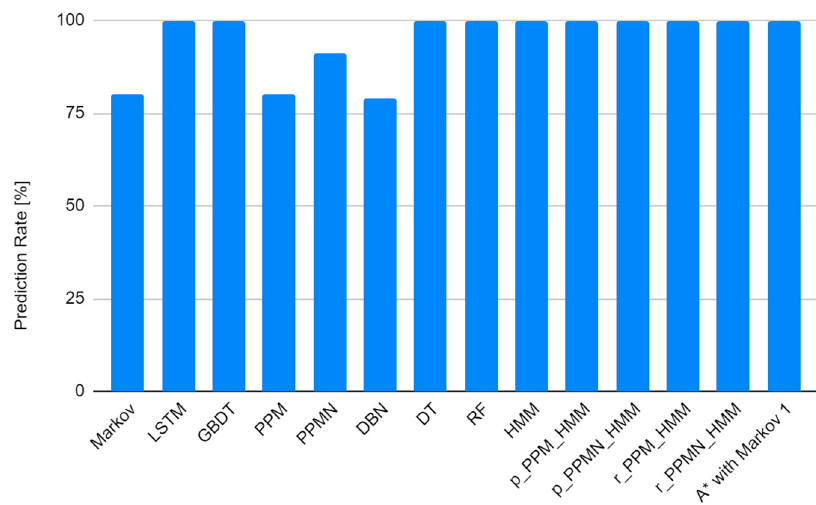
Figure 12. Accuracy on the students’ dataset.